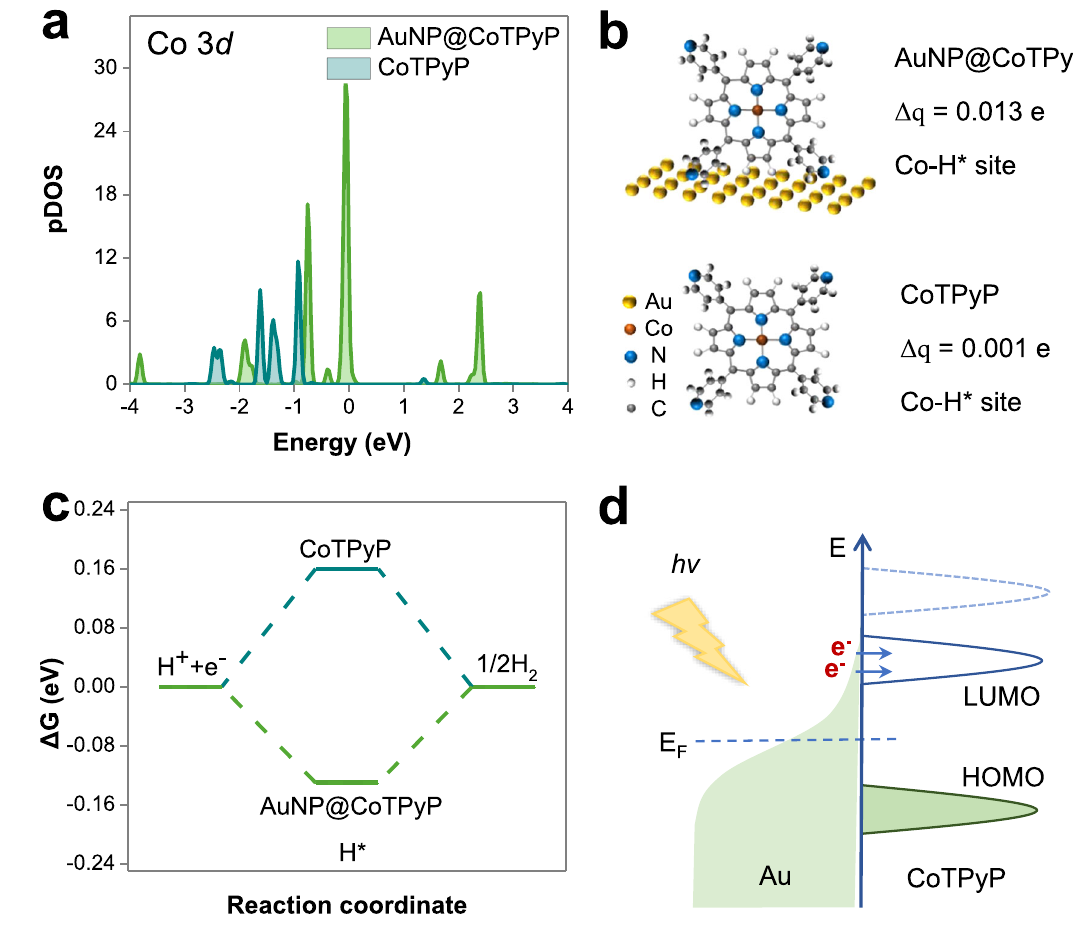
Fig. 6 | Theoretical DFT calculations of the AuNP@CoTPyP system. a Partial density of states (pDOS) of CoTPyP and AuNP@CoTPyP. b Differential charge densitiesofH*atCoTPyPandAuNP@CoTPyP. c GibbsfreeenergyofH*absorption